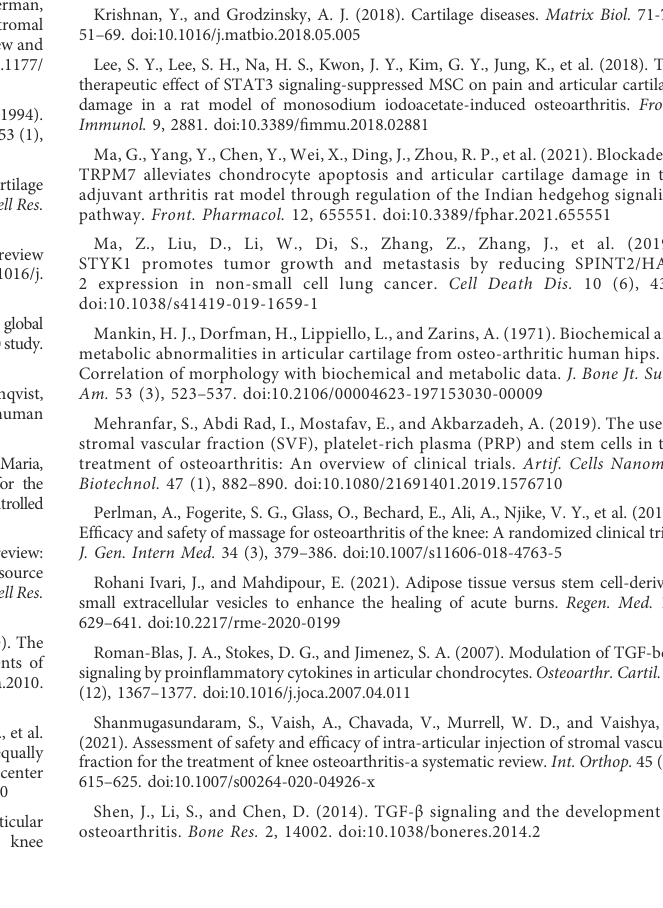
between NC, NF (Nanofat) and NFL group; (F) Neutrophils count between NC, NF (Nanofat) and NFL group. * p < 0.05 vs . NC group. SUPPLEMENTARY FIGURE S2 The cell viability of chondrocytes after NFL, exo (exosome) and TP (total protein)treatment. (A) Theproliferativerateofchondrocytesat24 h; (B) The proliferative rate of chondrocytes at 48 h. Values were shown as mean ± SD. * p < 0.05 vs . TNF- α group; ** p < 0.01 vs . TNF- α group; *** p < 0.001 vs . TNF- α group. SUPPLEMENTARY FIGURE S3 Western blot analysis of chondrocytes in TGF- β -Smad2/3 signaling pathway. (A) Western blot pro fi le of protein bands; (B) statistical analysis of Western blot protein bands; (C) Western blot pro fi le of protein bands; (D) Expressions of phospho-Smad2 in rat chondrocytes. (E) Expressions of phospho-Smad3 in rat chondrocytes. (F) Expressions of Smad2/3 in rat chondrocytes. ## p < 0.01 vs . NC group; * p < 0.05, ** p < 0.01 or *** p < 0.001 vs . TNF- α group. SUPPLEMENTARY FIGURE S4 (A) Sketch map of NFL production. SUPPLEMENTARY TABLE S1 The details of DEGs in